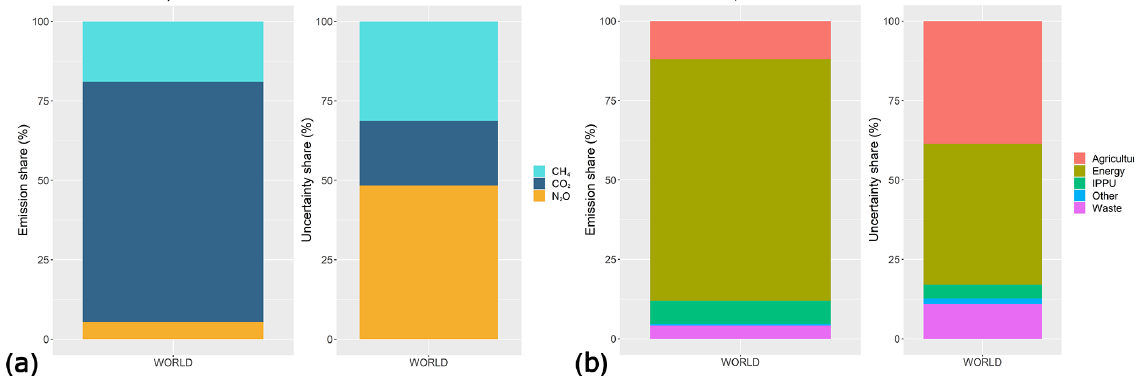
Figure 11. Global share of emissions and uncertainty by (a) gas and (b) category. IPPU stands for industrial processes and product use.